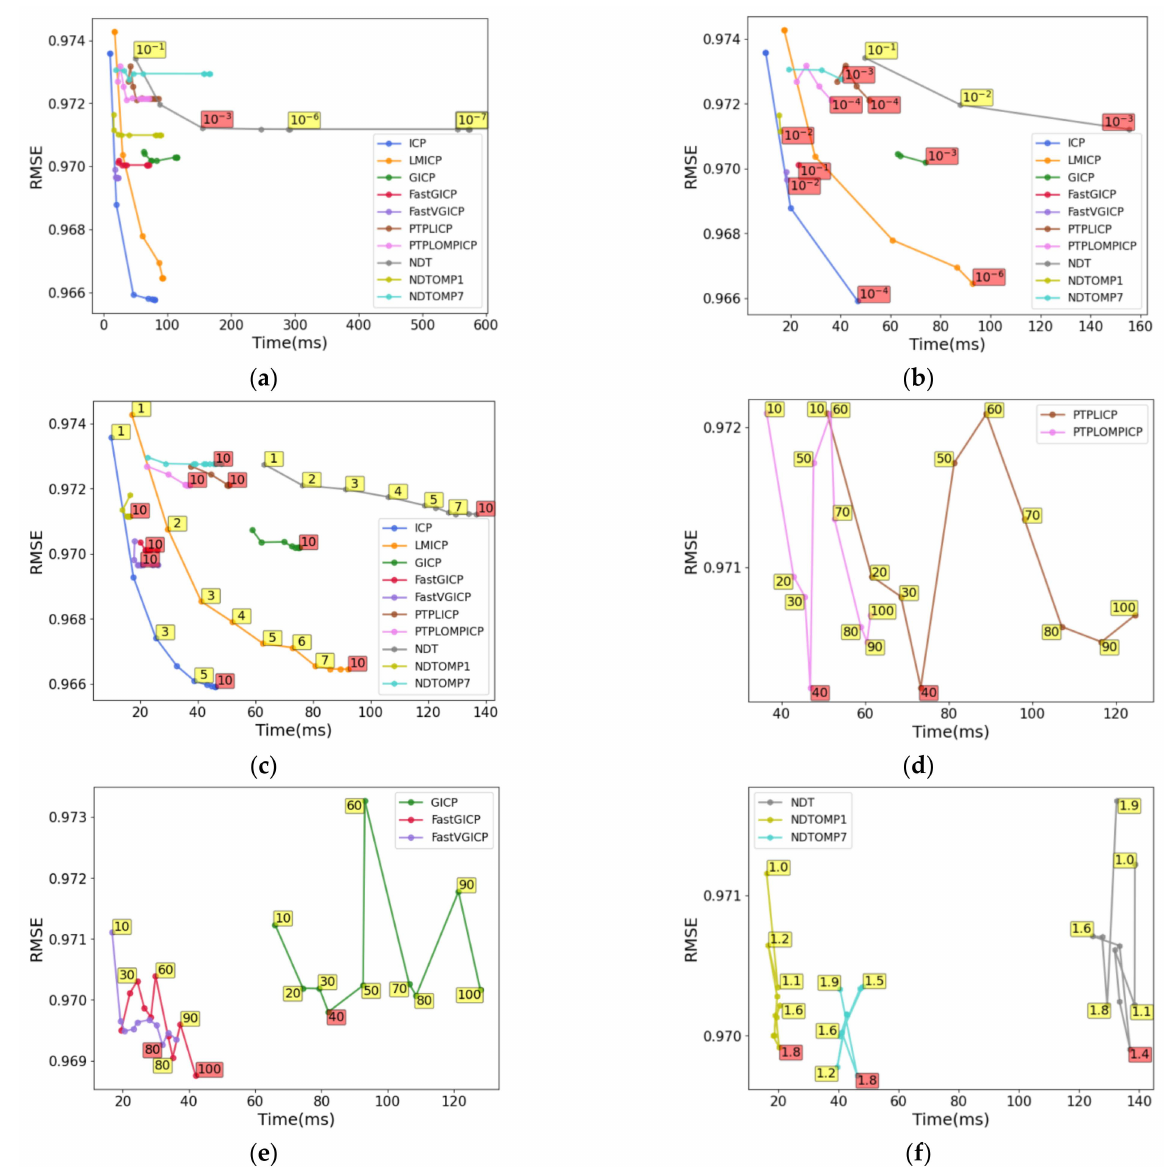
Figure 2. Result comparison of registration algorithms under different parameter settings. ( a ) Trans- formation epsilon comparison; ( b ) transformation epsilon result comparison; ( c ) maximum iterations comparison; ( d ) points for normals comparison; ( e ) points for covariances comparison; ( f ) NDT voxel